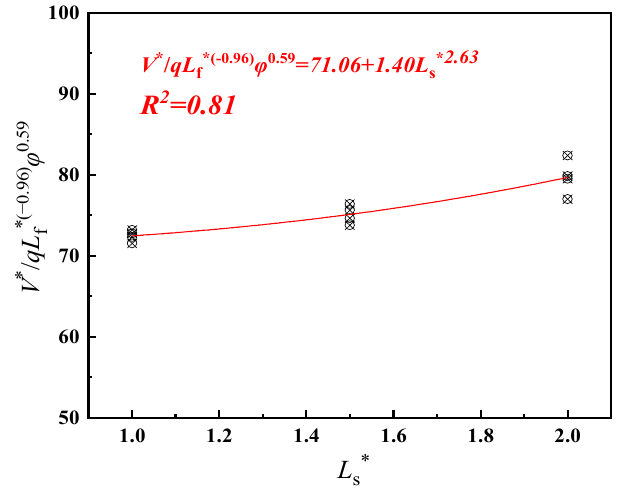
Figure 12. Dimensionless relation between inlet air velocity and shaft height ( L f > 330 m).